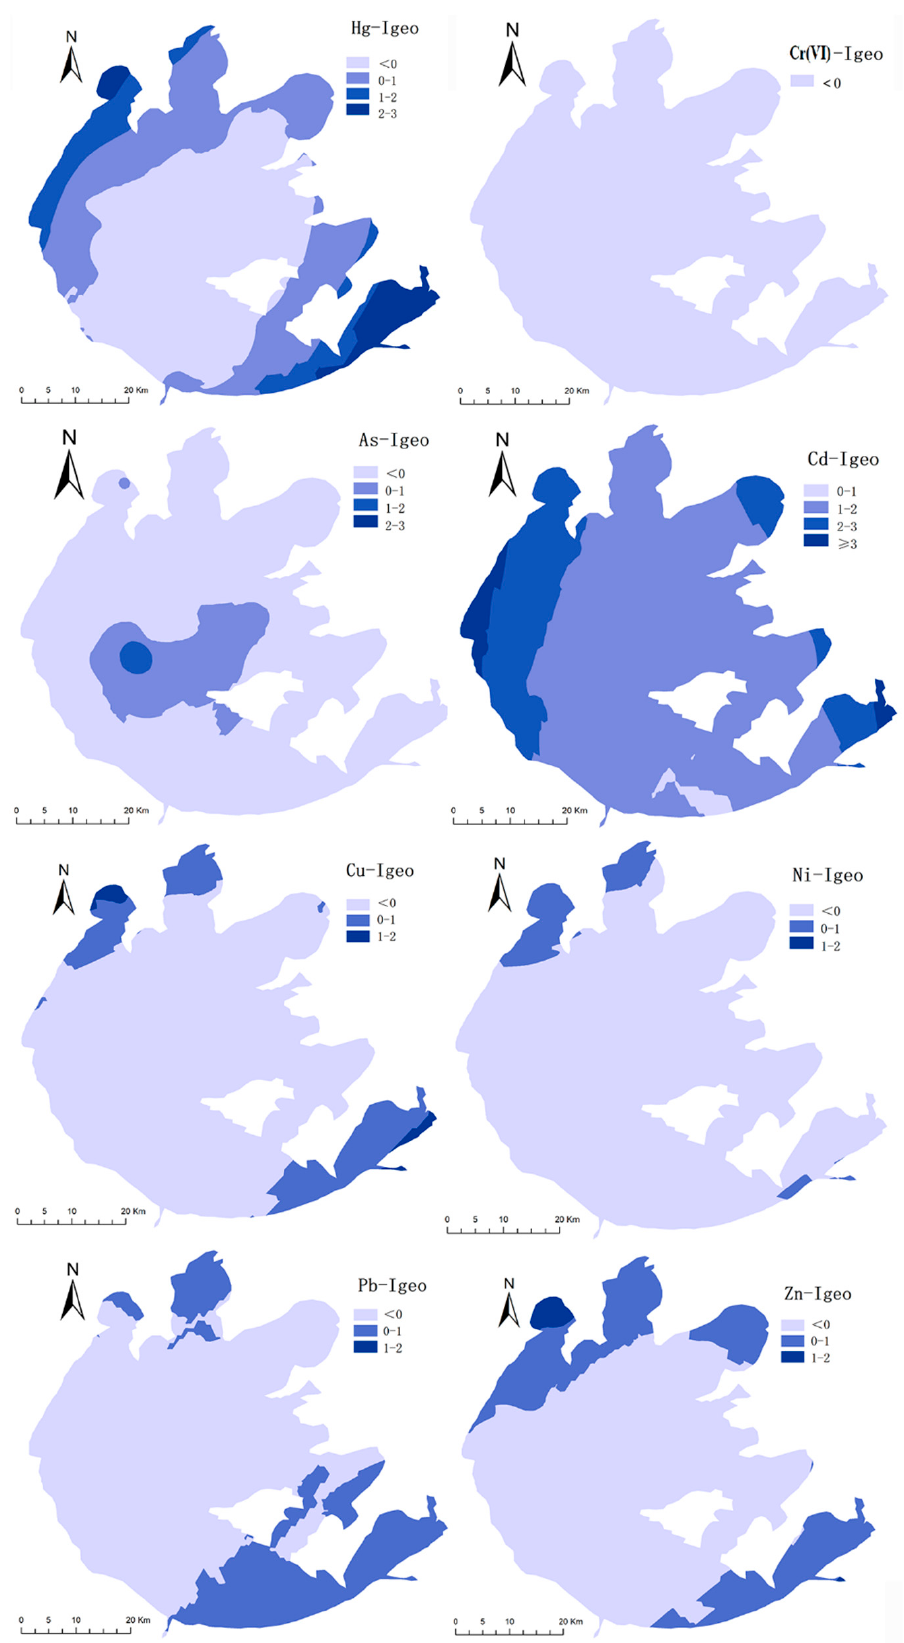
Figure 4. Spatial distributions of the geo-accumulation index (I geo ) of heavy metals in sediments.